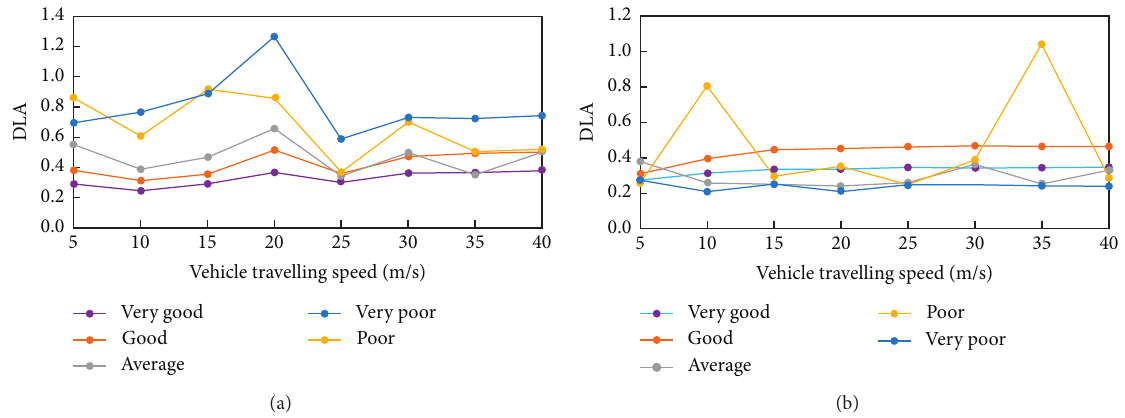
Figure 11: DLA for the midspan section of the main girder G : (a) DLA of the displacement; (b) DLA of the bending moment.